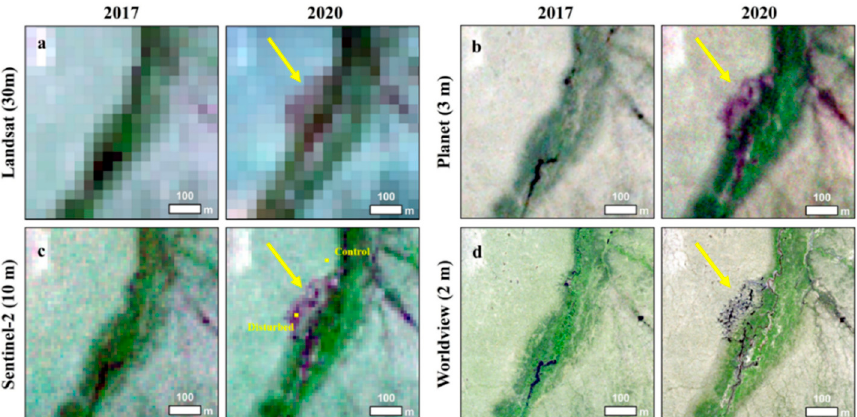
Figure 3. Multi-scale remote sensing image pairs bracketing the development of the beaver-induced permafrost degradation feature in the Swan Lake Creek drainage between 2017 and 2020. ( a ) Landsat-8, ( b ) Sentinel-2, ( c ) PlanetLabs, Inc. CubeSat Imagery, and ( d ) Worldview-2 imagery (Images copyright DigitalGlobe, Inc., Oakland, CA, USA). The feature is visible in all 2020 images, but it is best resolved at spatial resolutions of 10 m and finer. The yellow pixels highlighted in the 2020 Sentinel-2 image represent the locations of the disturbed and control sites for the multi-spectral indices time series analysis.